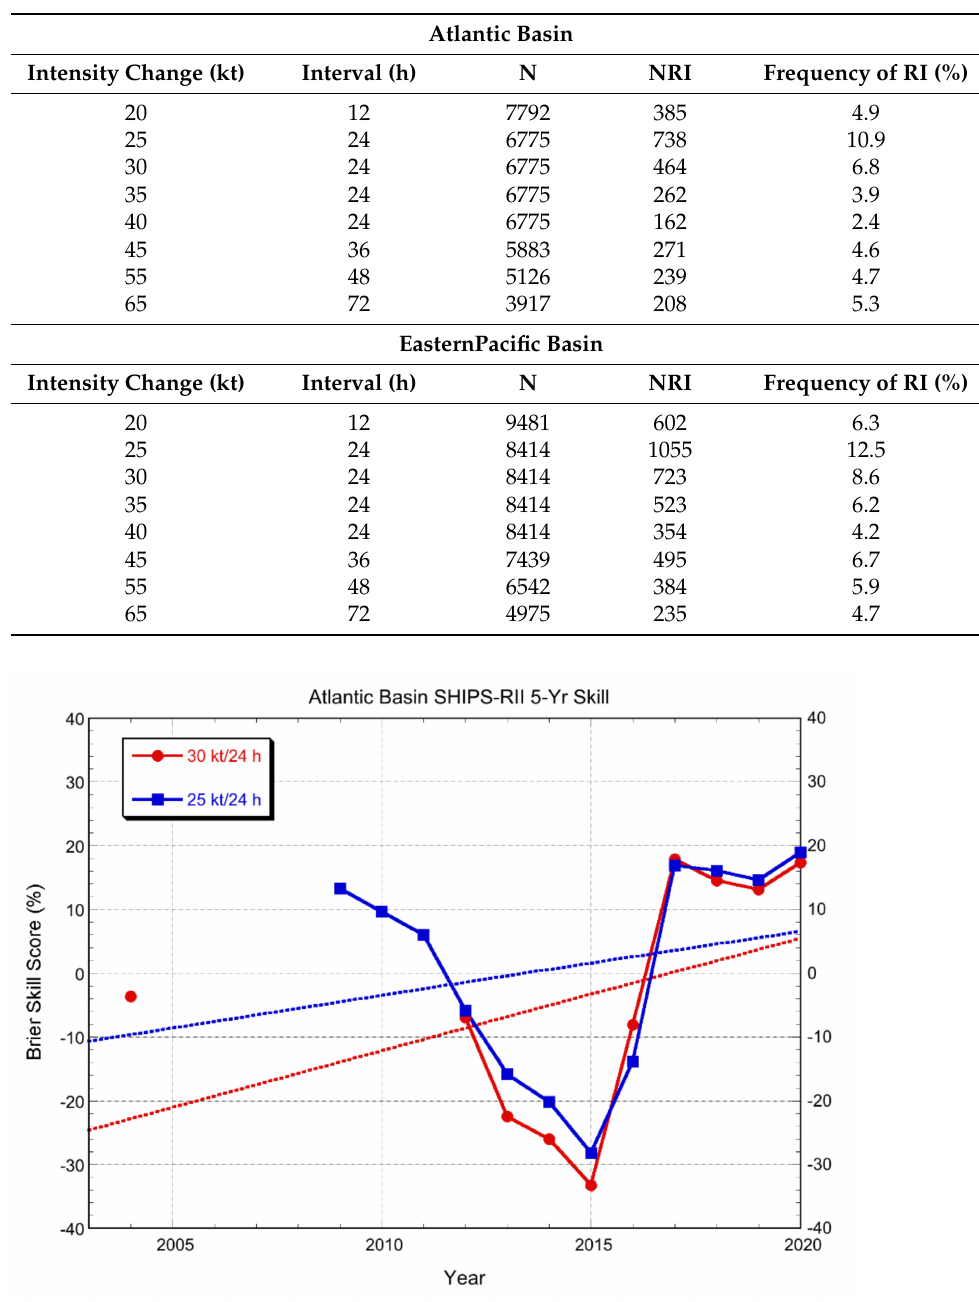
Table 7. Climatological frequency of RI in the Atlantic and eastern Pacific basins for the 1989–2019 period. For eight sets of RI threshold definitions, the table shows the total number of over-water intervals (N), the number of intervals meeting the RI intensity change threshold (NRI), and the corresponding frequency of RI (NRI/N).